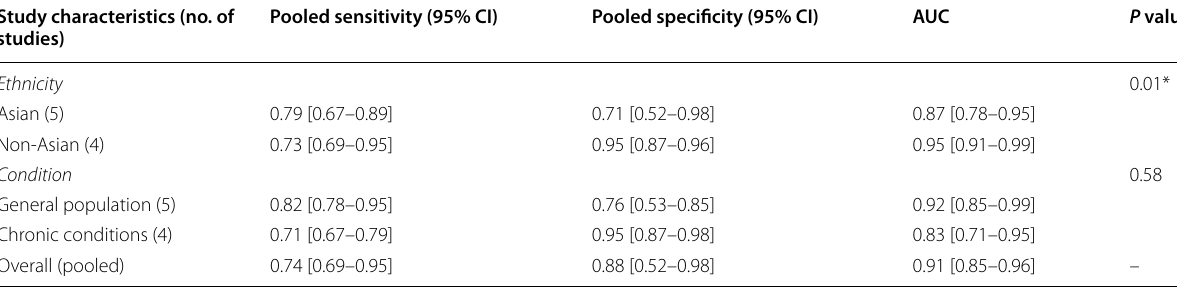
AUC area under the